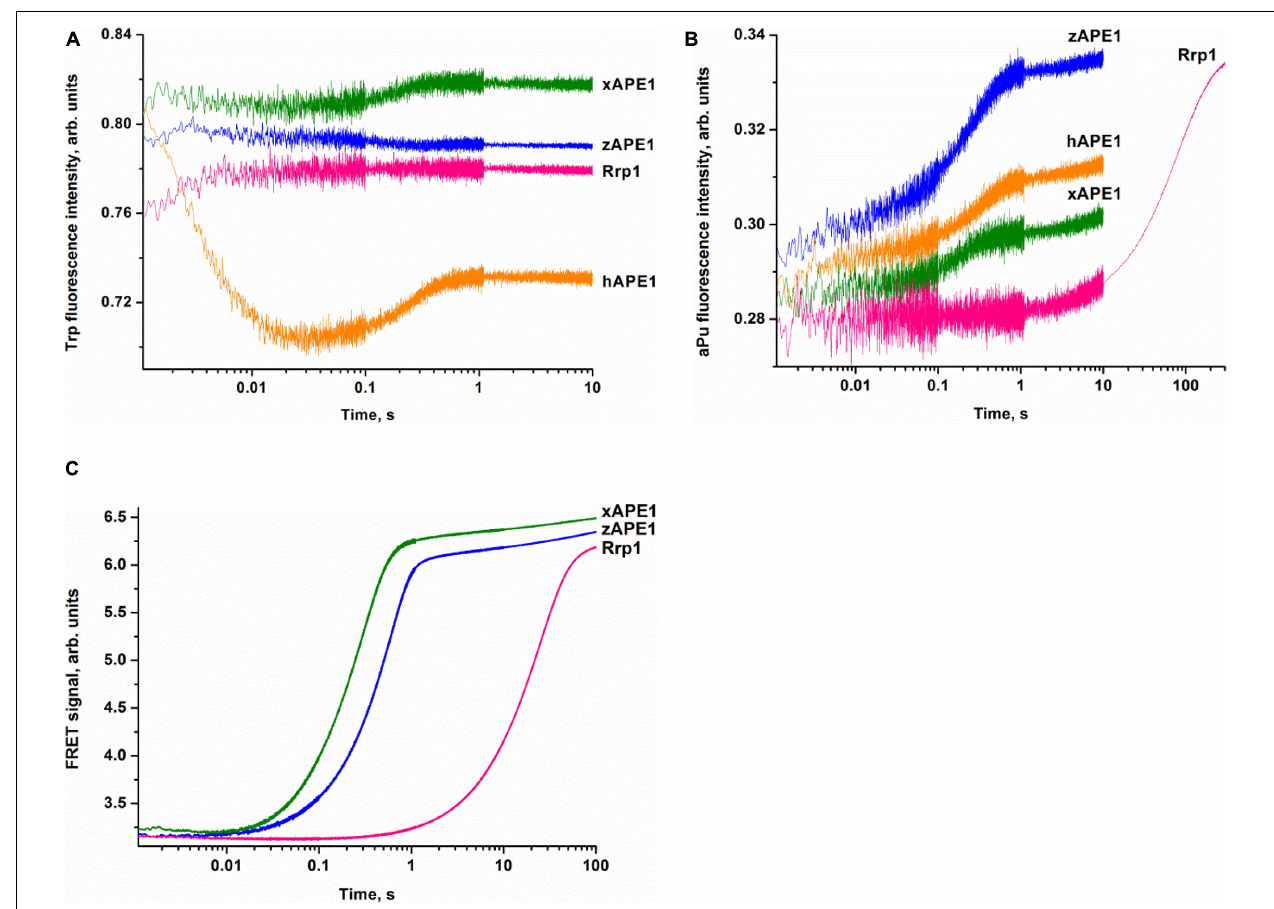
FIGURE 3 | Interactions of AP endonucleases with DNA containing an F-site, as monitored by changes in the fluorescence intensity of Trp (A) , aPu (B) , or FRET signal (C) . (DNA substrate) = (enzyme) = 1.0 µ